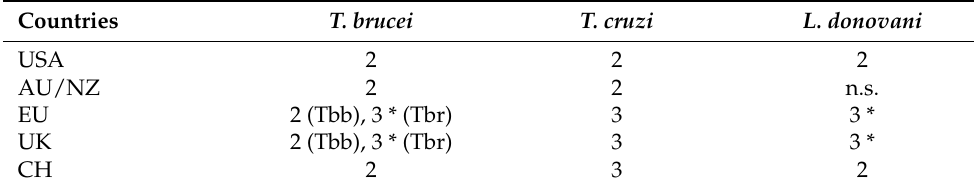
Table 4. Risk group and biosafety level categorization of T. brucei , T. cruzi and L. donovani (in